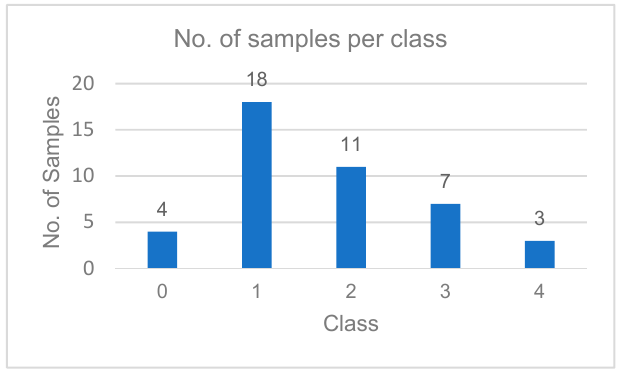
Figure 6. Bar chart showing number of samples per class .